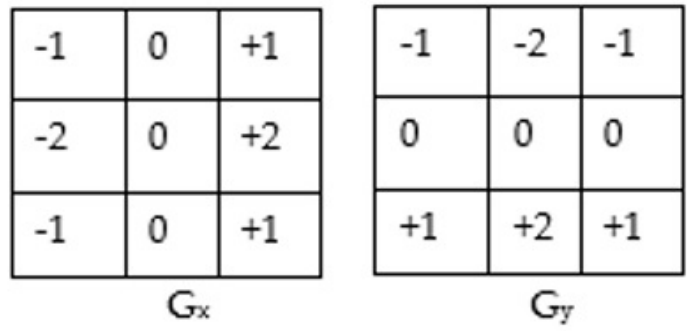
Figure 1. Convolution mask for canny edge detection. The formula for magnitude and direction finding is given